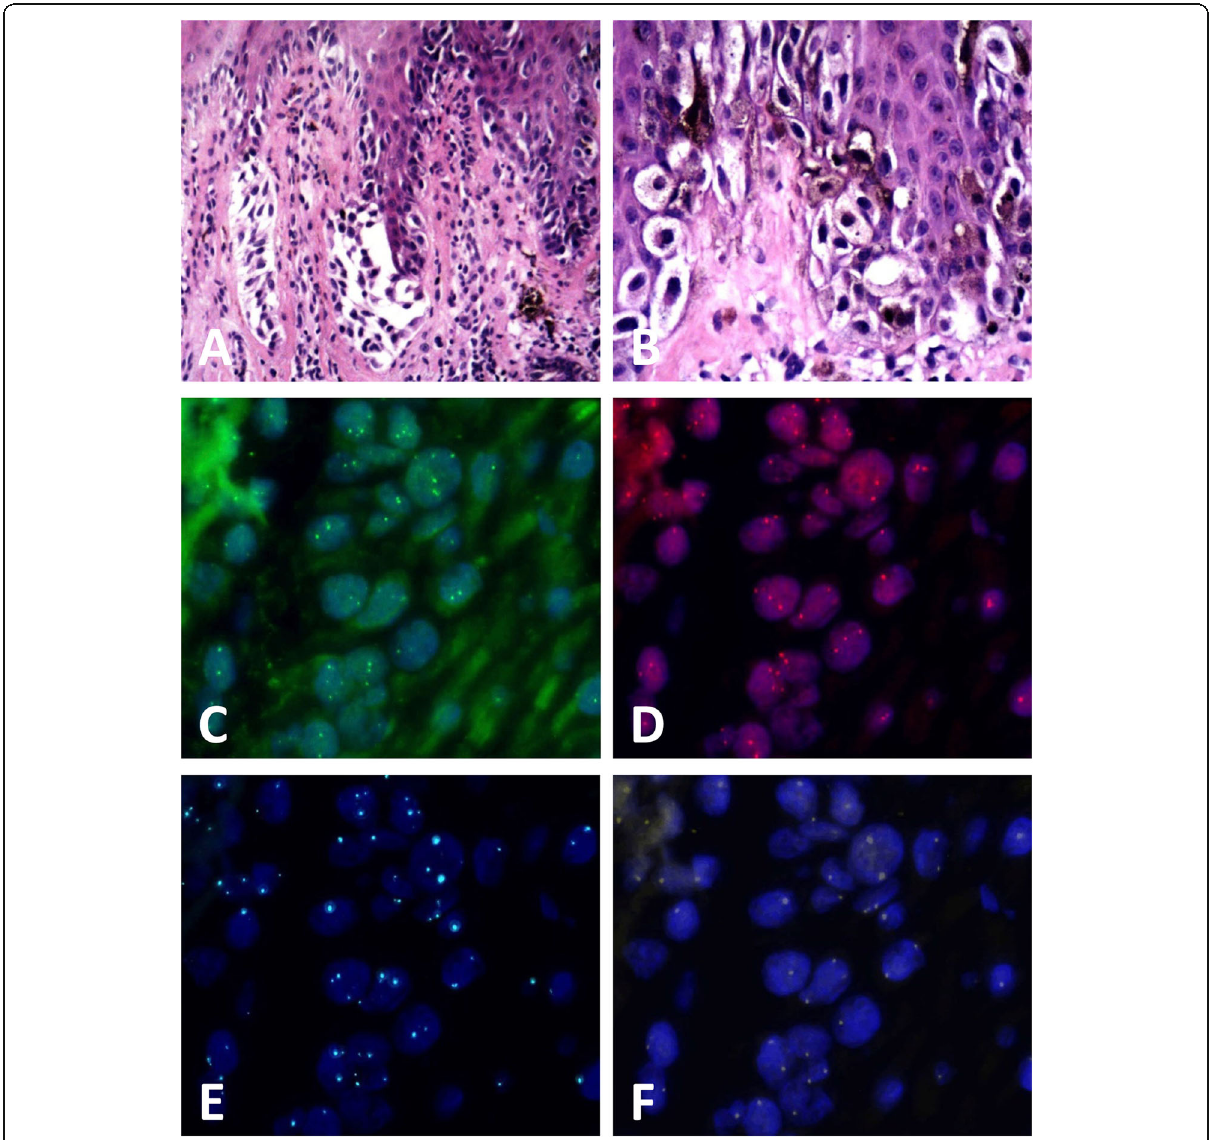
Fig. 1 Case of melanoma in situ positive by fluorescence in-situ hybridization (FISH) detection. a Melanocytes proliferated successively or in nests in the basal layer of the epidermis (hematoxylin and eosin, H&E staining), ( b ) high-power magnification showed moderate to severe atypia of the melanocytes(H&E staining), ( c-f ) FISH images showed the ( c ) gain of CCND1 (green signals), ( d ) gain of RREB1 (red signals), and ( f ) loss of MYB (gold signals) relative to CEP6 (aqua signals). While the gain of RREB1 ( d ) relative to CEP6 ( e ) was not